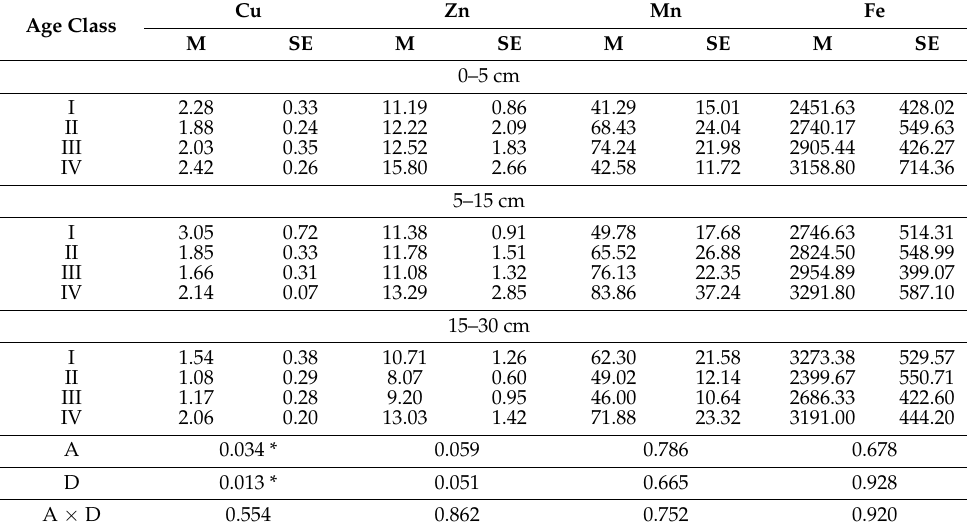
Table 4. Mean (M) with standard error (SE) concentrations (mg/kg of the soil) of the microelements in the three top layers (0–5, 5–15 and 15–30 cm) of the soil under silver birch regeneration by age class (I, II, III and IV—1–4, 5–8, 9–12 and 13–17 years,